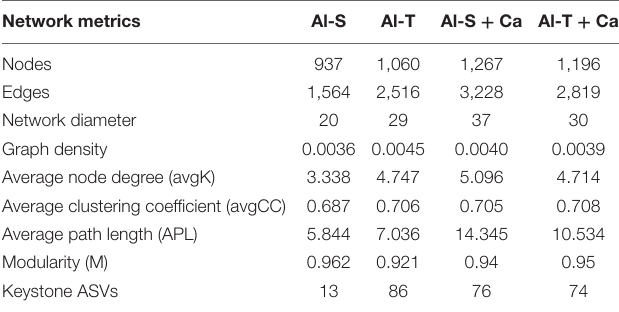
TABLE 4 | Topological properties of co-occurring networks and the number of keystone